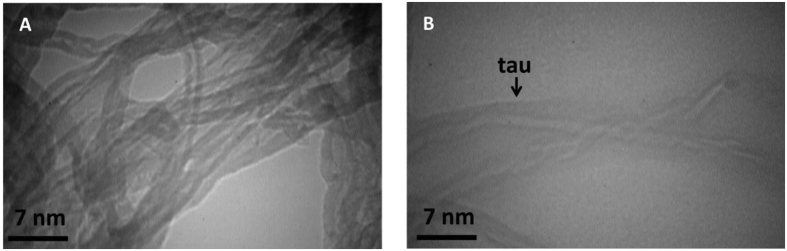
TEM observation.TEM image of SWCNT in the absence (A) and presence (B) of tau protein. Tau protein is absorbed on the surface of SWCNT and demonstrates disassembly of SWCNT.